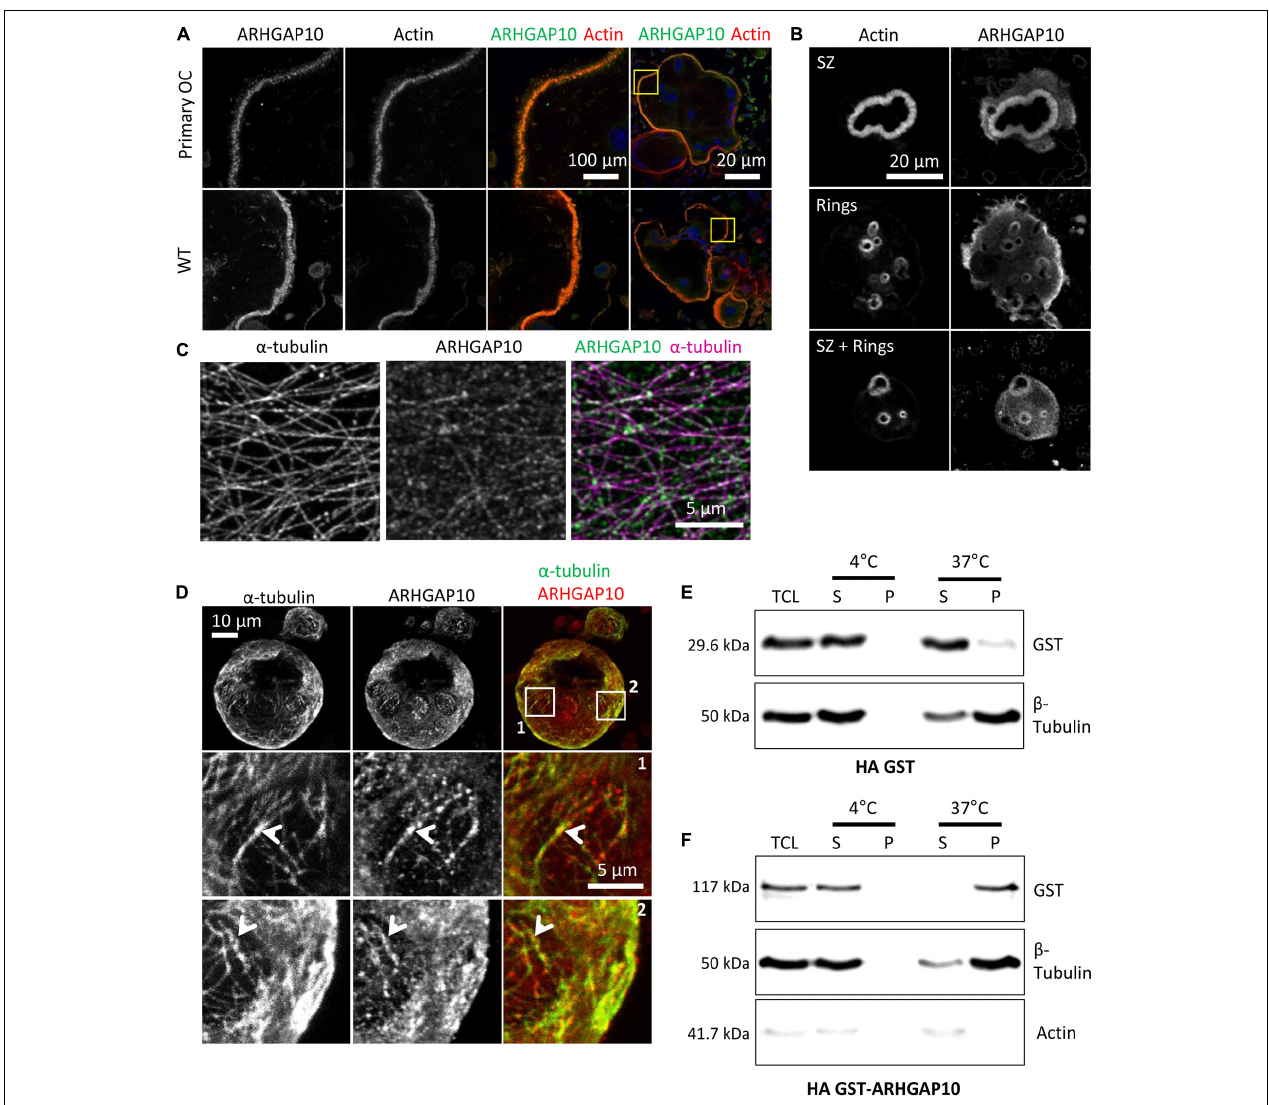
FIGURE 6 | ARHGAP10 is associated with both actin and microtubules. (A) Representative MIP images of RAW264.7 derived or primary (primary OC) osteoclasts seeded on glass and stained for ARHGAP10, actin, and DNA. Left images show enlargement of boxed areas in the images on the right. (B) Representative MIP images showing ARHGAP10 and actin localization in WT and Tubb6 KO osteoclasts sitting on ACC. (C) Representative single plan confocal image of a WT osteoclast stained for ARHGAP10 (green) and α -tubulin (pink). (D) Representative MIP images of a WT osteoclast sitting on ACC and stained for ARHGAP10 and α -tubulin. Boxed areas in top images are enlarged below, to show ARHGAP10 colocalization with microtubules (arrowheads). (E,F) Immunoblot analysis of lysates from HEK293T cells expressing HA-GST (E) or HA-GST-ARHGAP10 (F) , and subjected to microtubule pelleting assays at 4 ◦ C or 37 ◦ C. ARHGAP10 co-sediments at 37 ◦ C with microtubules in the pellet, which contains β tubulin but is devoid of